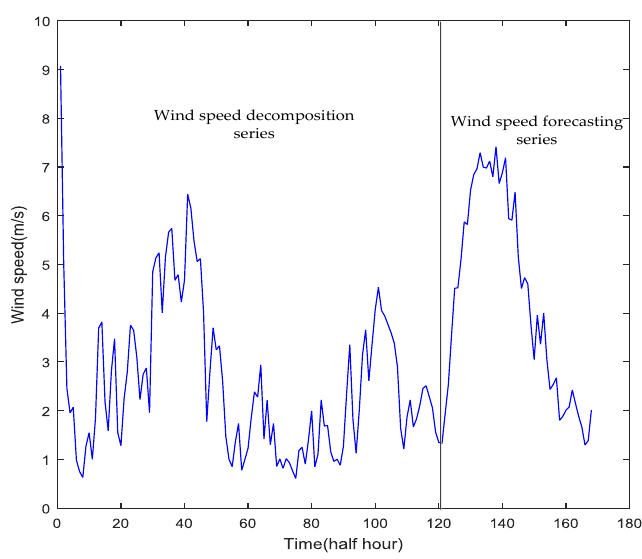
Figure 3. Wind speed series used to verify the effectiveness of the new approach (from 18 February 2004 to 20 February 2004).